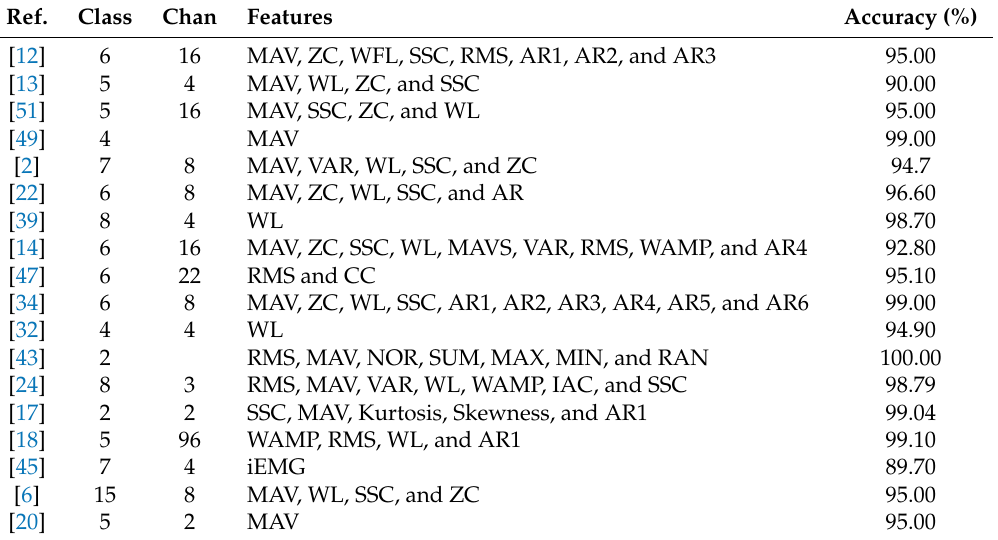
Table 5. EMG signals classification methods with time-domain features. Ref.